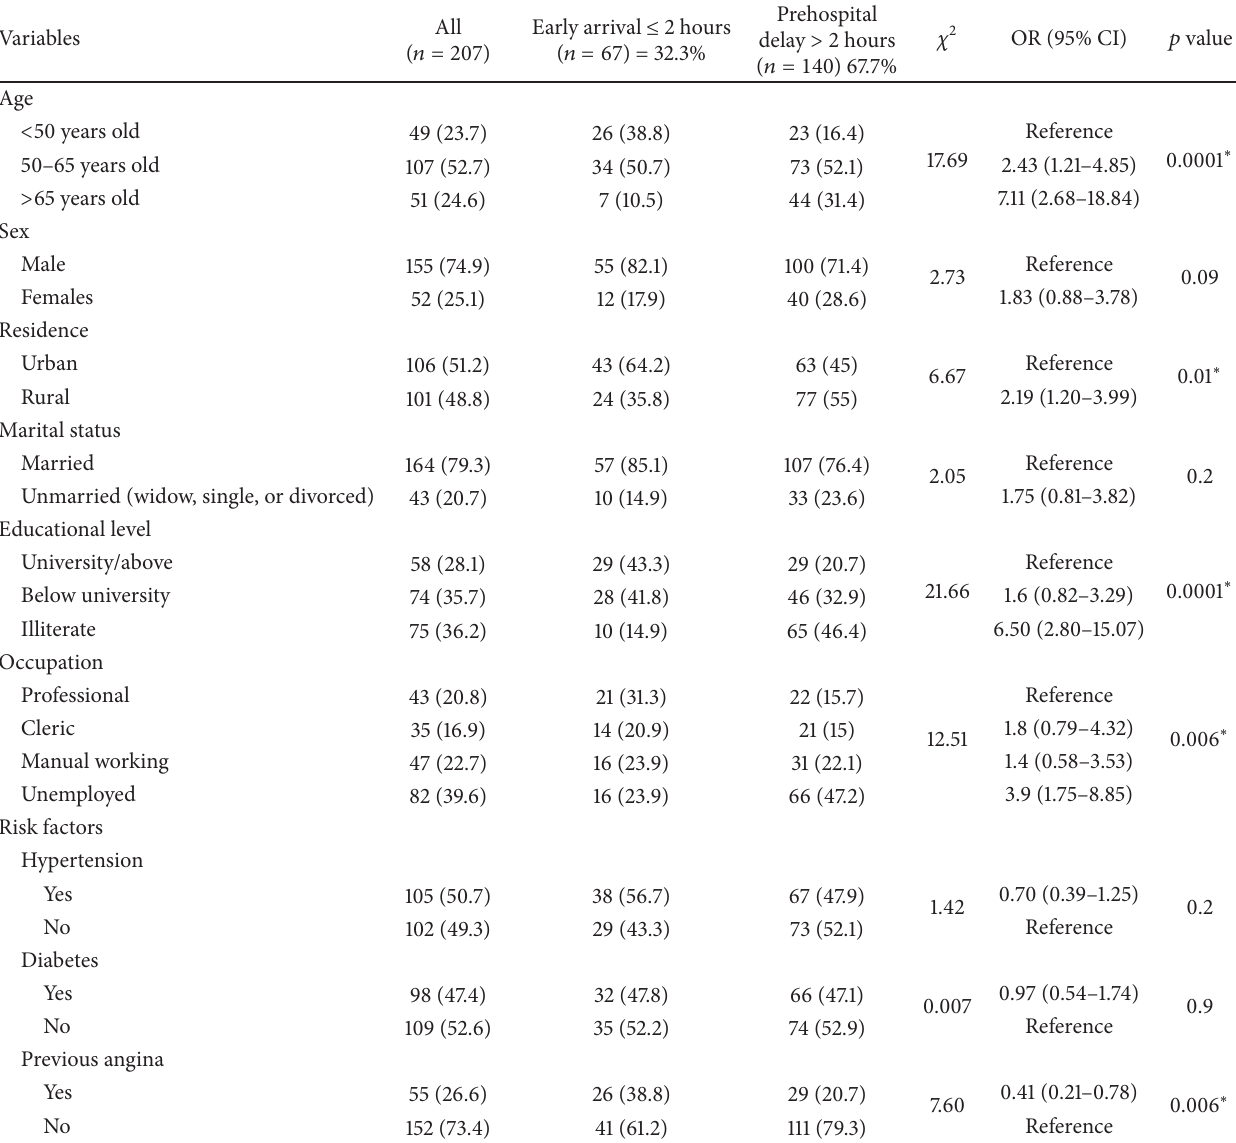
Table 1: Prehospital delay in relation to baseline and demographic characteristics of the participants.